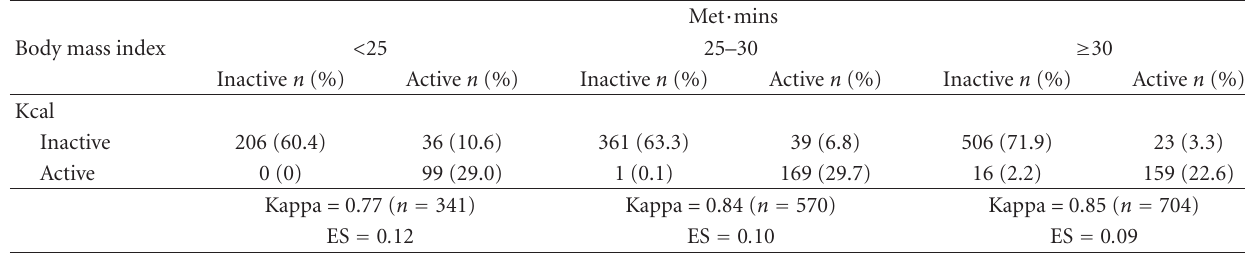
(a) Comparison of agreement between Kcal method and Met · mins method across BMI categories.